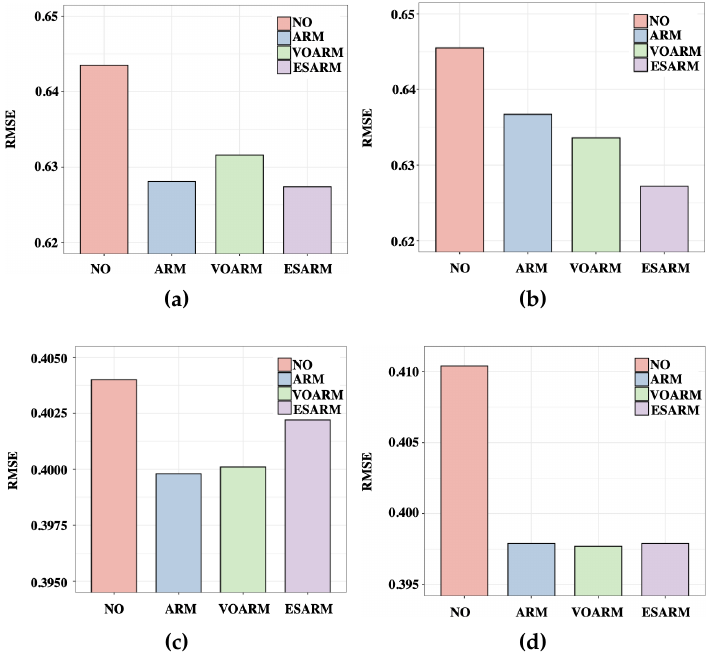
Figure 5. Performance in set-rating prediction under different settings, using different pre-training methods. ( a ) MF, RealSet-explicit. ( b ) NCF, RealSet-explicit. ( c ) MF, RealSet-implicit. ( d ) NCF, RealSet-implicit.